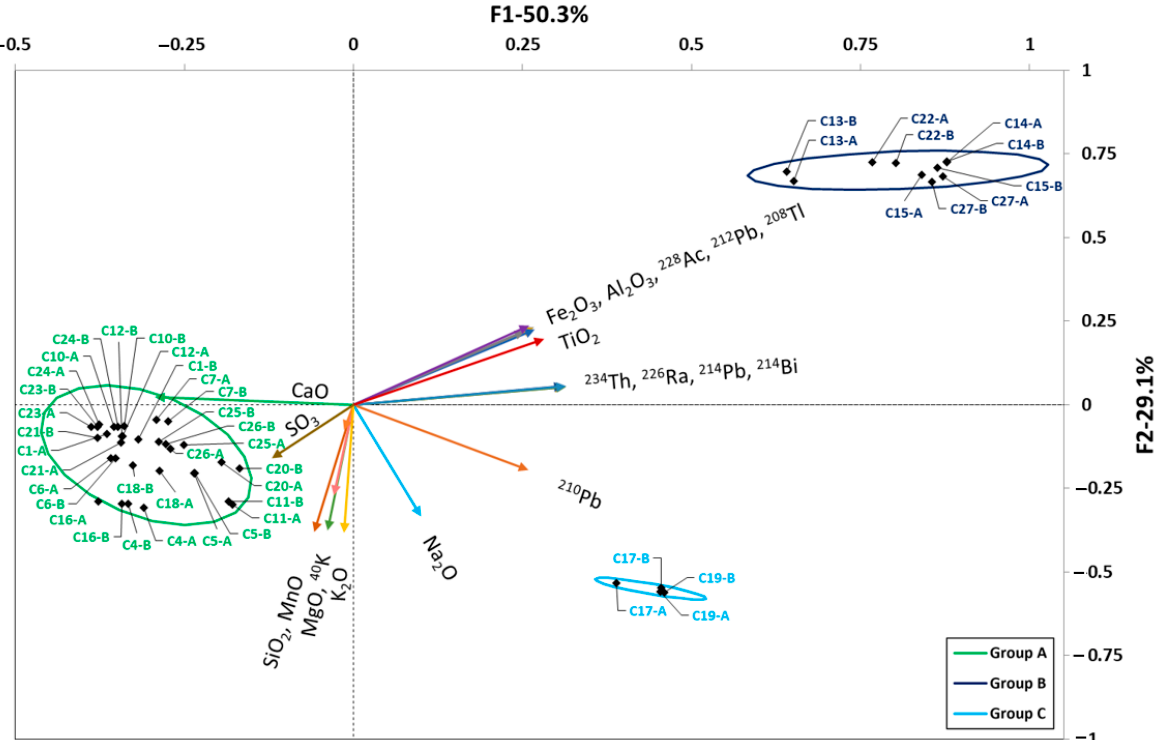
Figure 3. HJ–Biplot for the cements analyzed. The variables studied were CaO, SO 3 , SiO 2 , MnO, MgO, K 2 O, Na 2 O, TiO 2 , Fe 2 O 3 , Al 2 O 3 , 234 Th, 228 Ac, 226 Ra, 214 Bi, 214 Pb, 212 Pb, 210 Pb, 208 Tl, and 40 K, represented as a vector. The scores of the cement samples were calculated from the weights of the studied variables. The cements were grouped into three sets according to their content: (a) CaO and SO 3 ; (b) Fe 2 O 3 , Al 2 O 3 , TiO 2 , thorium series ( 228 Ac, 212 Pb, and 208 Tl) and uranium series ( 234 Th, 226 Ra, 214 Pb, and 214 Bi); and (c) Na 210 Pb. The correlations between the studied variables